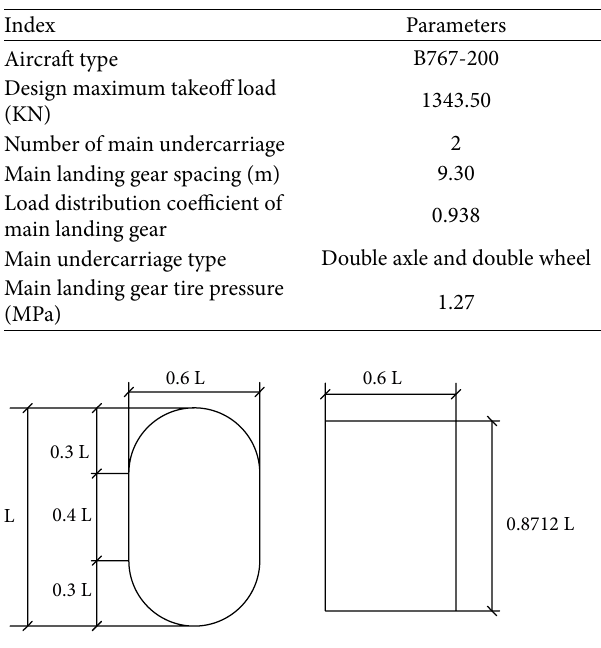
Figure 2: Single wheel load distribution of aircraft: (a) primary load distribution, (b) equivalent load